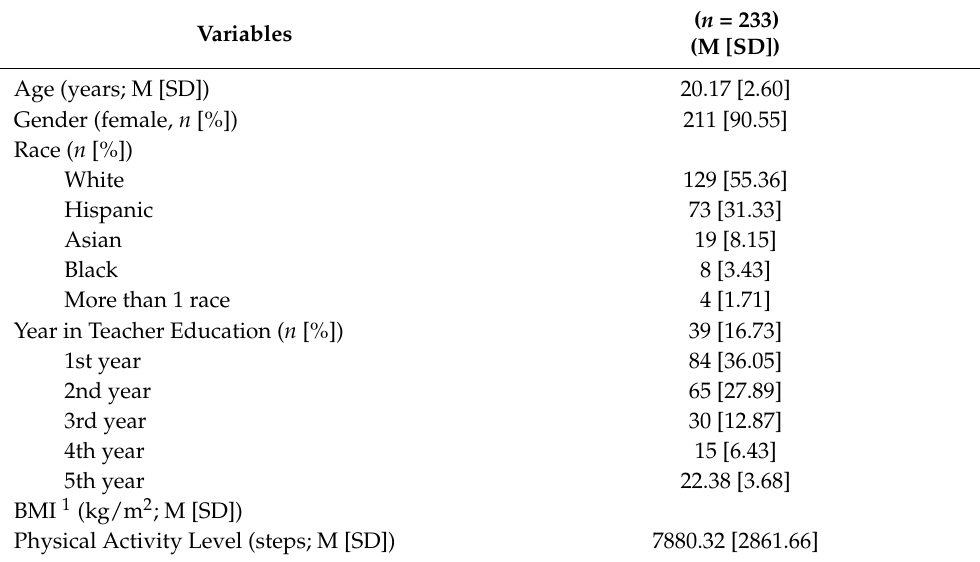
Table 2. Participant